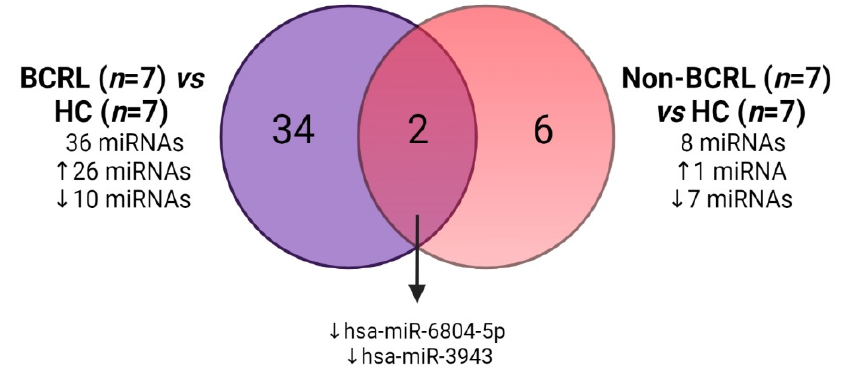
Figure 3. Venn diagram representing overlapping miRNA expression between BCRL vs. HCs and non-BCRL vs. HCs. A total of 36 miRNAs were differentially expressed in the BCRL group (purple and left-hand circle) and 8 miRNAs were differentially expressed in the non-BCRL vs. HCs (8 miRNAs, red and right-hand circle). The direction of the regulation is represented with an upward pointing arrow (upregulated) and a downward pointing arrow (downregulated).